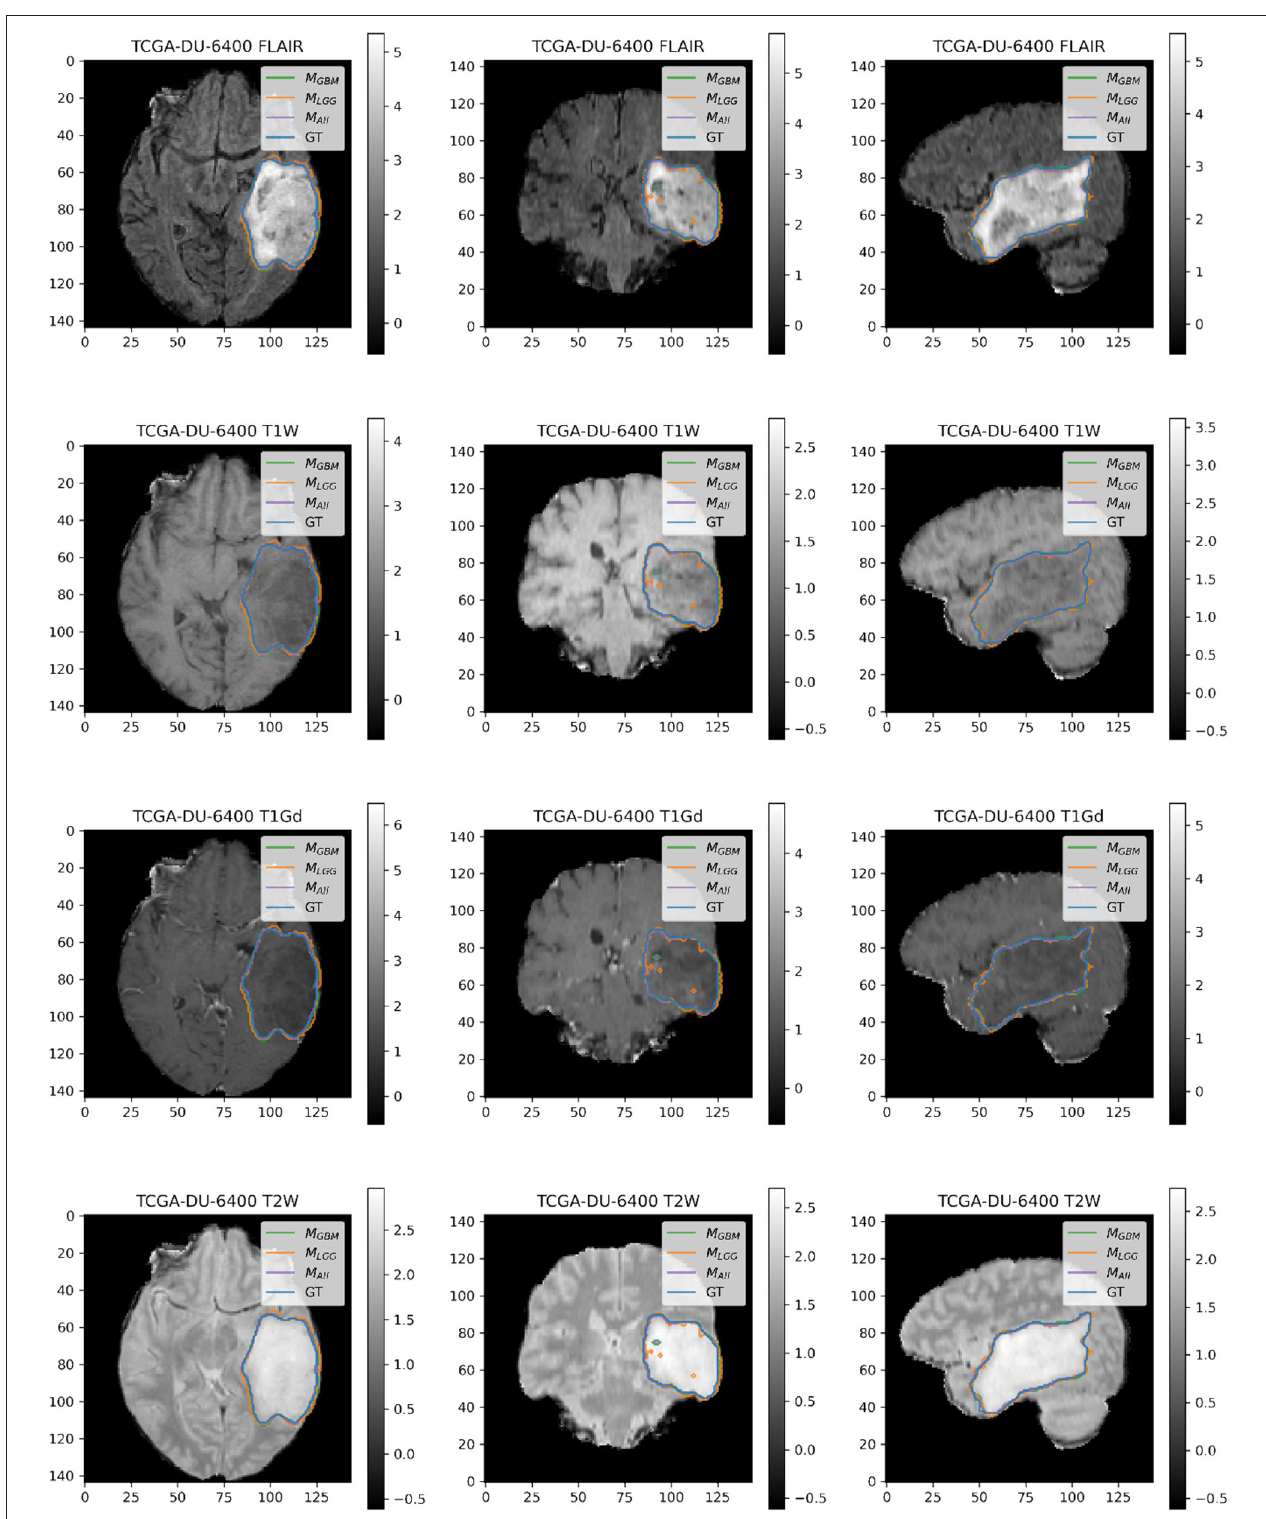
FIGURE 7 | Patient TCGA-DU-6400 belongs to D LGG and has a tumor in the left temporal parietal region. We selected this patient as an example because it has consistently good performance for metrics (Sens, B.Acc, Dice, Jac.C) across all models. This LGG has clear margins, and the classic signature of FLAIR enhancement and no T1-Gd